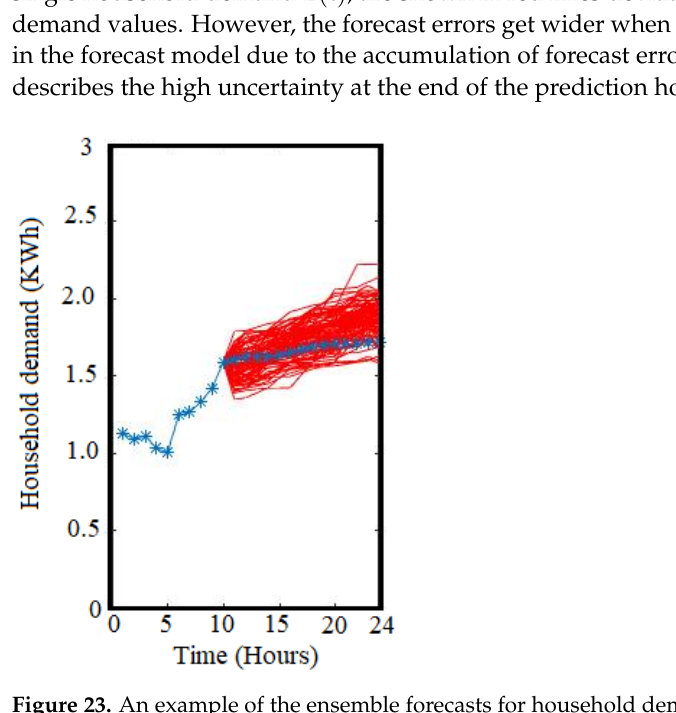
Figure 23. An example of the ensemble forecasts for household demand.